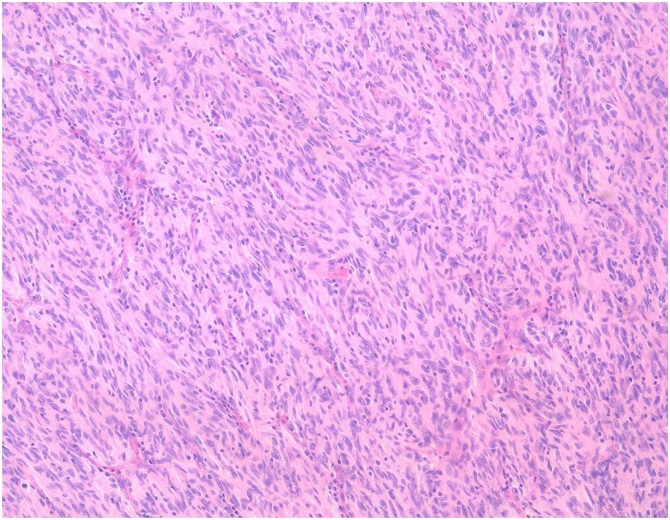
Microscopic findings show that spindle cells with dense nuclei proliferate intricately, forming short fascicles.